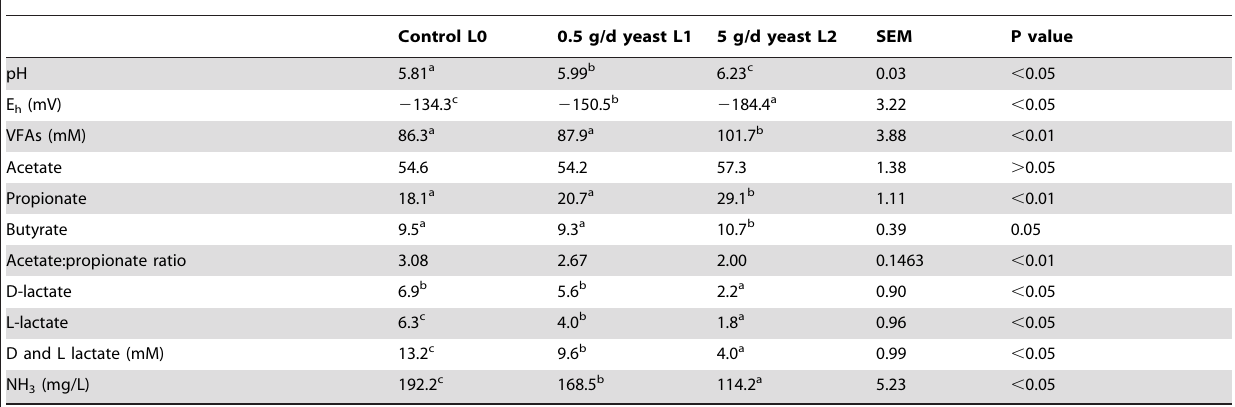
Table 2. Effect of yeast on the physicochemical parameters of the rumen.